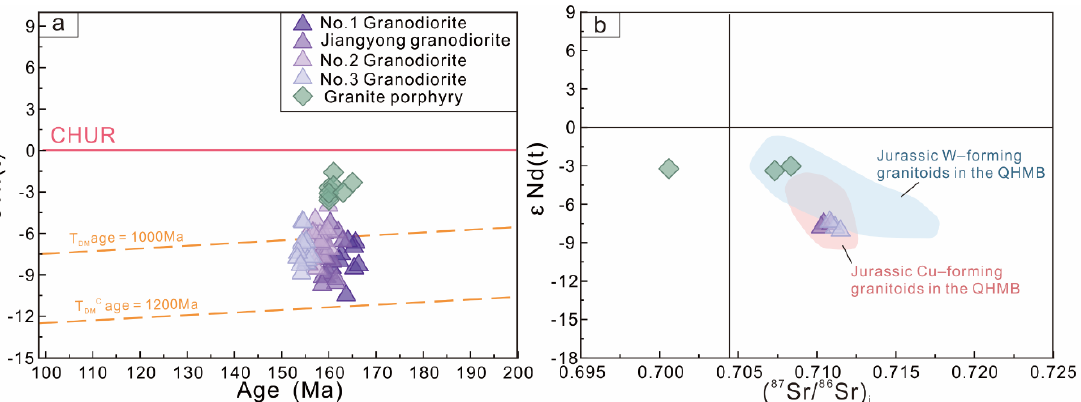
Figure 8. Plots of ( a ) zircon 206 Pb/ 238 U age vs. εHf(t) for the Tongshanling granitoids, and ( b ) ( 87 Sr/ 86 Sr) i vs. εNd(t). (Sr –Nd isotopic composition fields of the Jurassic Cu-forming and W-forming granitoids in the QHMB are after [59]).